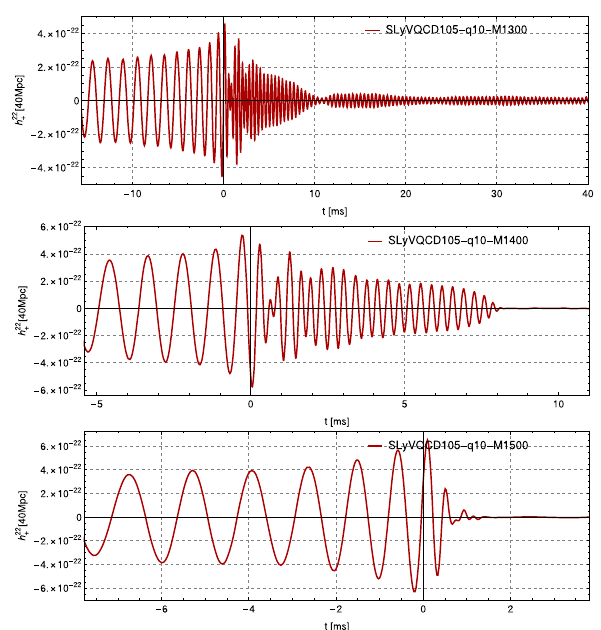
Fig. 22 Gravitational waves ( h 22 + at the distance of 40 Mpc) obtained from numerical simulations with the intermediate V-QCD(SLy) EOS with n tr = 1 . 61. The top, middle, and bottom rows show the signal from simulations with M = 1 . 3 M (cid:3) , 1 . 4 M (cid:3) , and 1 . 5 M (cid:3) ,